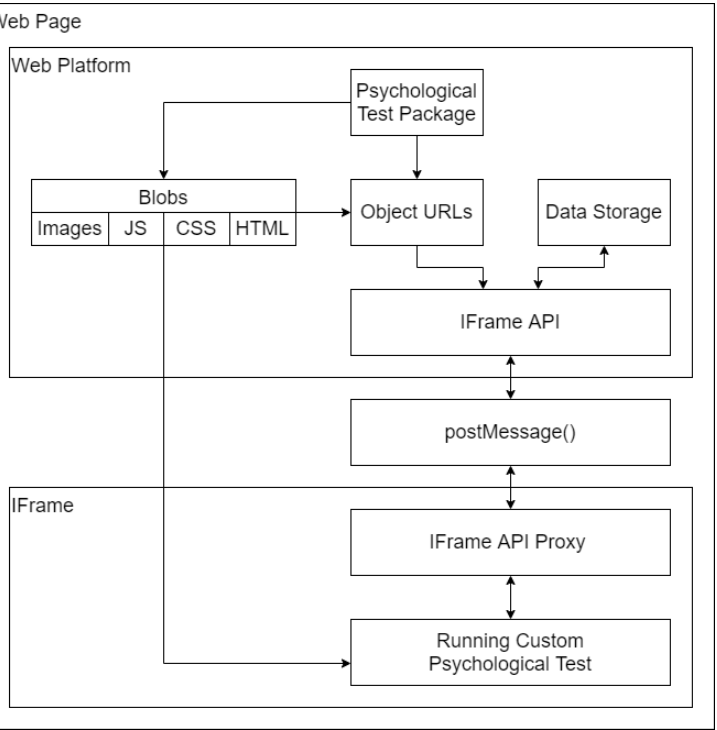
Figure 4. Scheme of interaction and data exchange between the platform web page and the pro- grammable psychological test in the iframe.